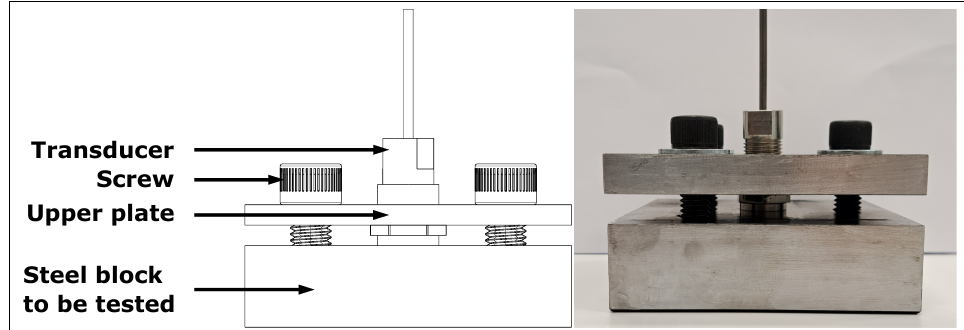
Figure 2. Transducer A or B installed onto low-carbon steel